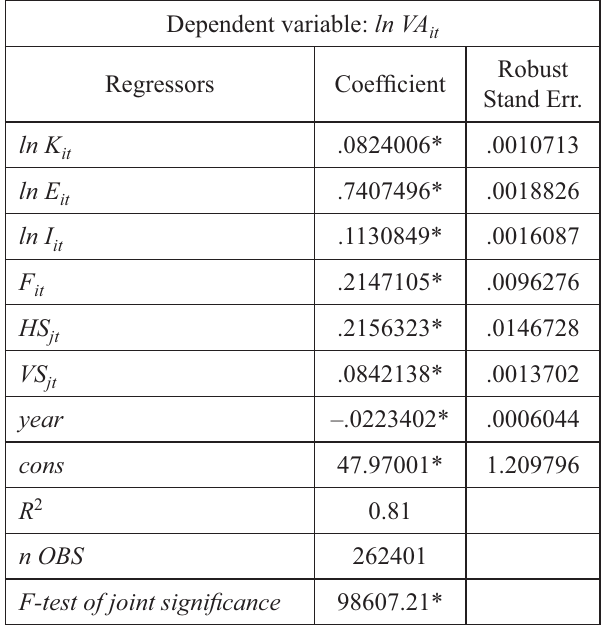
Table 3.1. Results of the pooled OLS estimation of